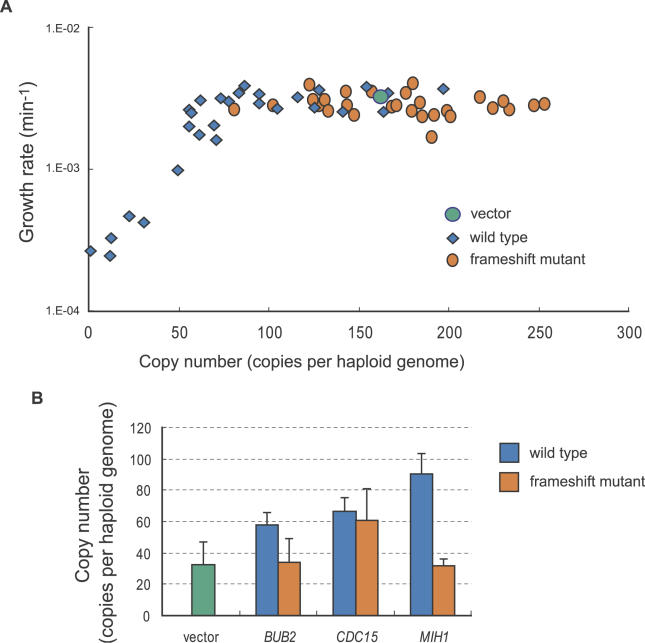
Control Experiments with Frame Shift Mutants in the gTOW Experiment(A) A scatter plot showing the correlation of maximum growth rates and plasmid copy numbers with wild-type CDC genes and their frame shift mutants determined in the gTOW experiment.(B) Plasmid copy numbers with wild-type and frame shift mutants in the gTOW experiment in the uracil− condition. The data used in the graphs are listed in Table S2.